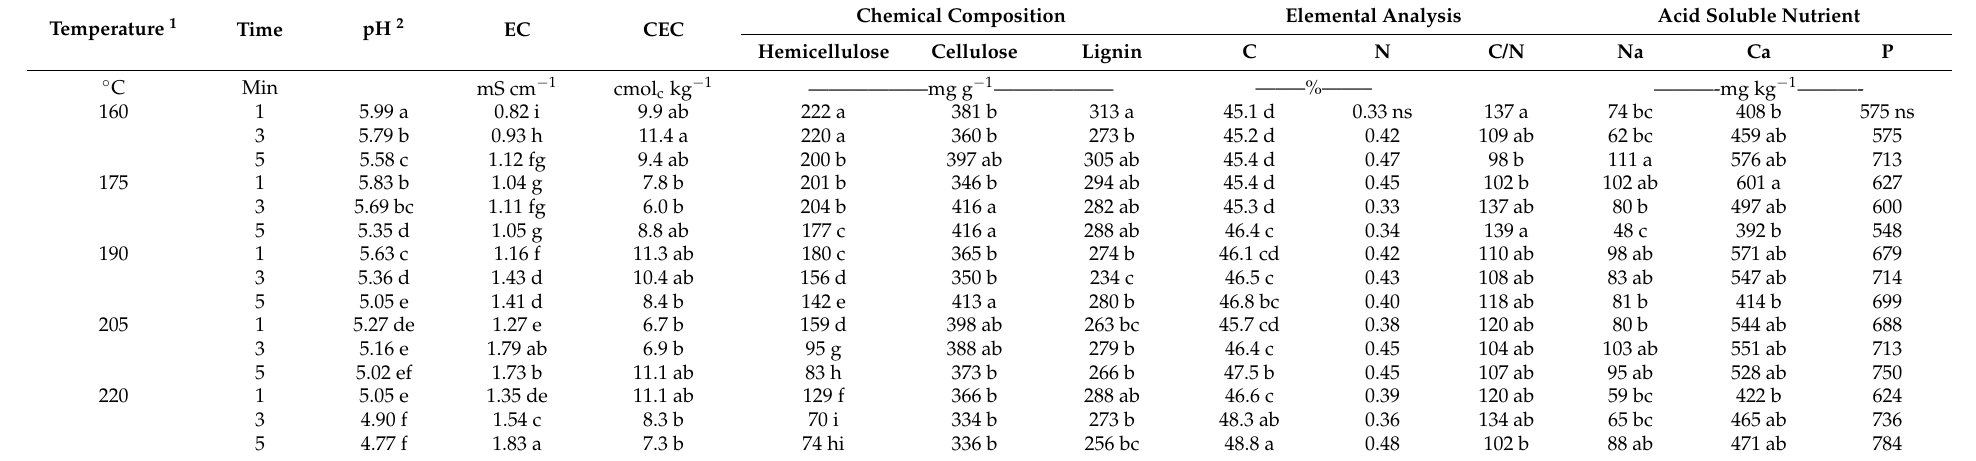
Table 2. Chemical properties of pruning waste as affected by temperature × retention time